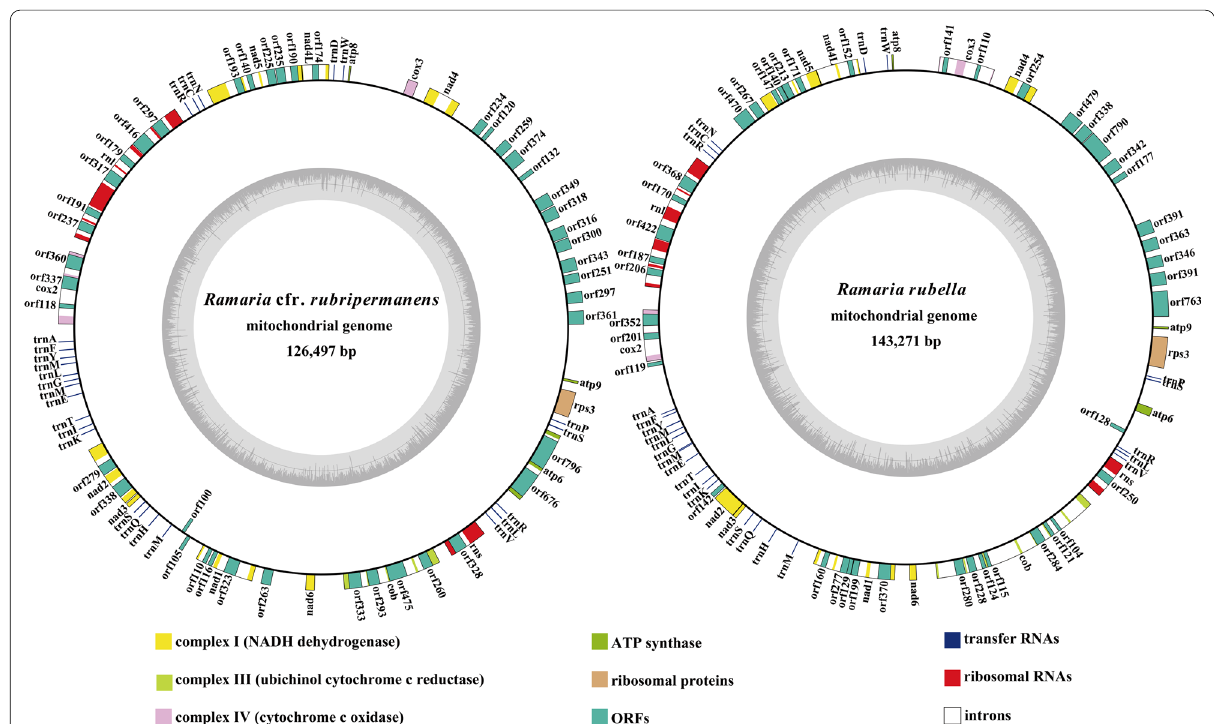
Fig. 1 Circular maps of the two Ramaria mitochondrial genomes. Genes are represented by different colored blocks. Colored blocks outside each ring indicate that the genes are on the direct strand, while colored blocks within the ring indicates that the genes are located on the reverse strand. The inner grayscale bar graph shows the GC content of the mitochondrial sequences. The circle inside the GC content graph marks the 50%